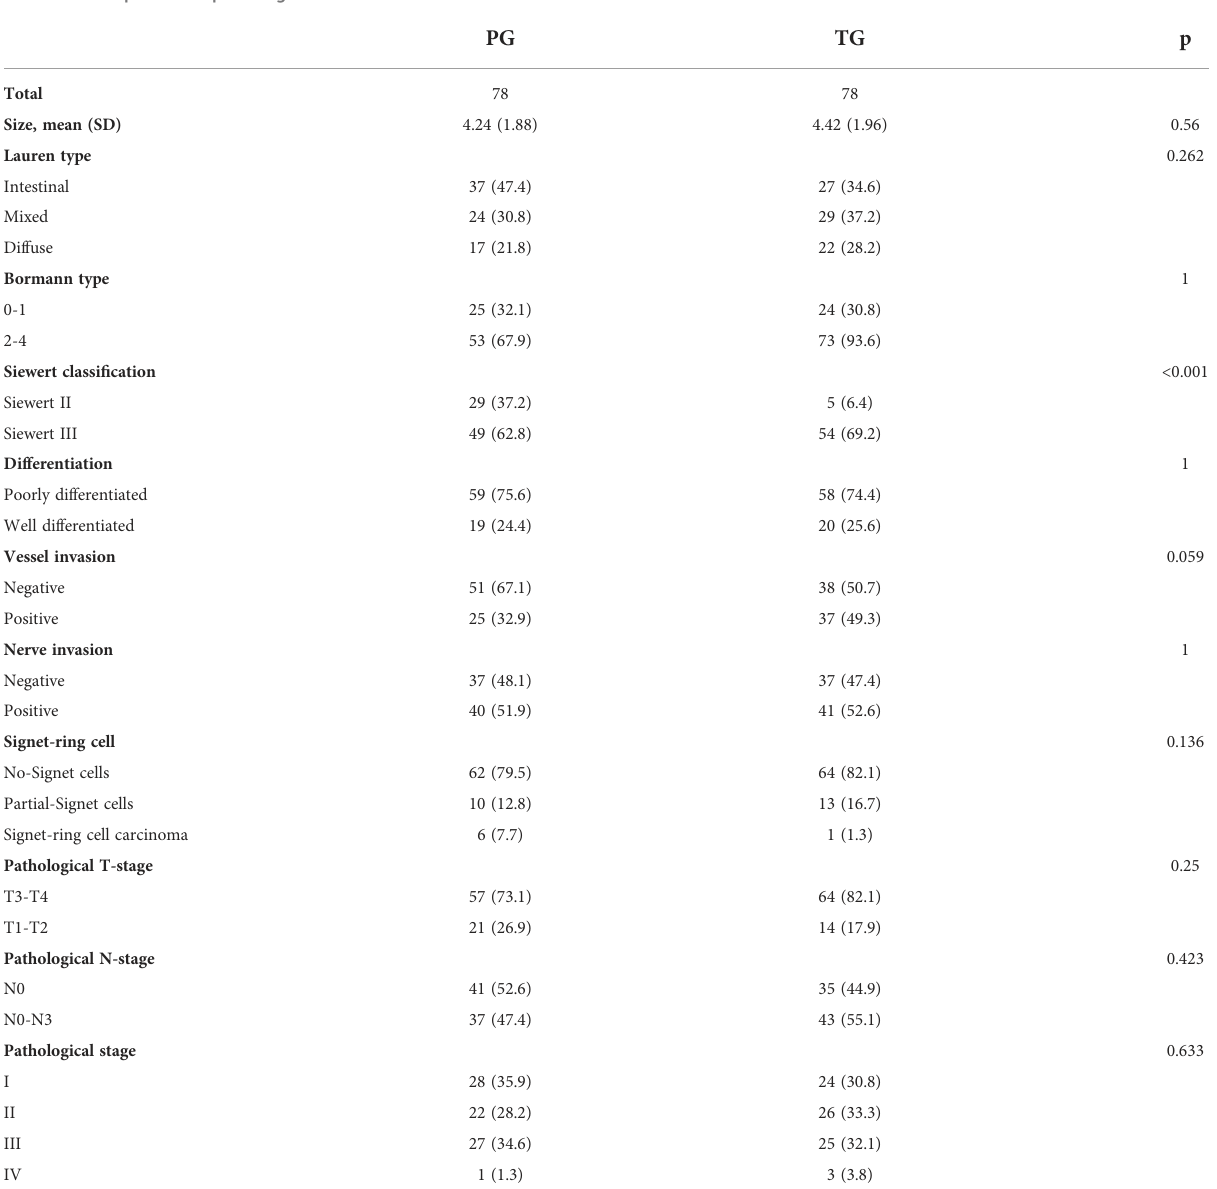
TABLE 2 Comparison of pathological